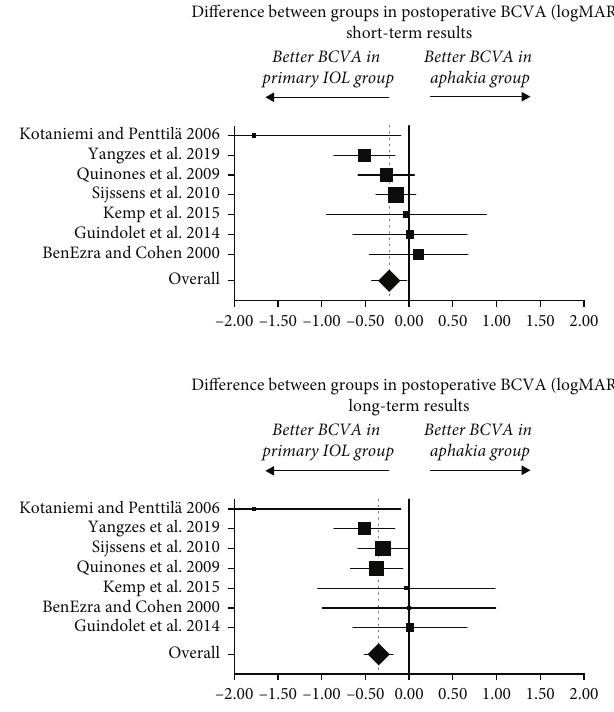
Figure 3: Forest plot of the differences between groups in postoperative short-term (1 year, top) and long-term (5 years, bottom) outcomes in the best-corrected visual acuity (BCVA). Summary estimates are weighted mean difference (WMD) in logMAR. To allow for easier interpretation of the overall study results, we refrained from adjusting figure to the study outcomes from Kotaniemi and Penttil¨a [20] which were subject to very large confidence intervals ( − 3.44 to − 0.09 and − 3.44 to − 0.09, respectively, for short-term and long-term results).